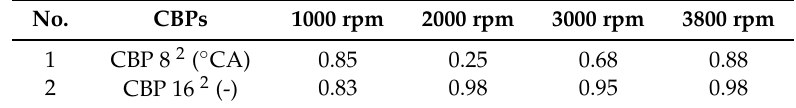
Table 9. Evaluated CBPs (Table 1) in calibration loop 3 at full-load operating points. No. CBPs 1000 rpm